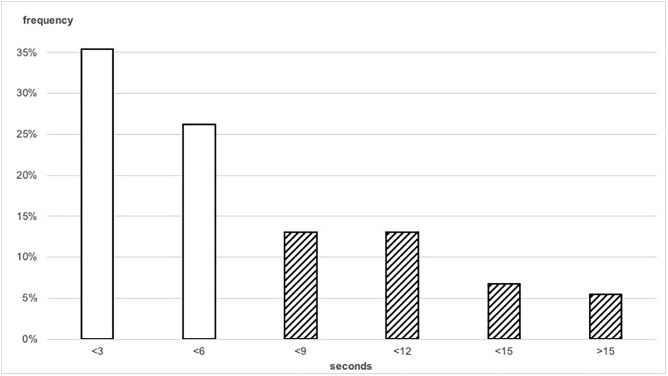
Histogram for the ball-in-hand times, pooled into three-second bins. Crosshatched bars illustrate groups that exceed the six second maximum.